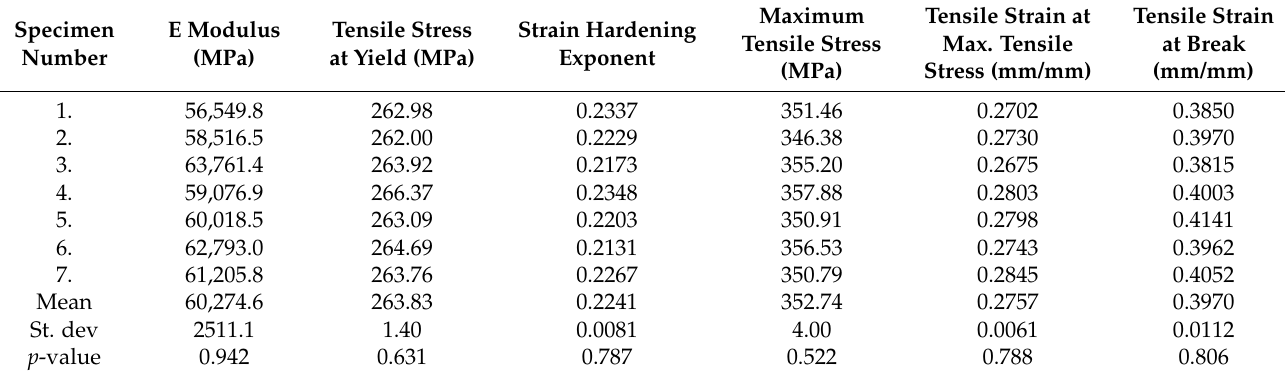
Table 4. Results of uniaxial tensile test for unwelded specimens collected on transversal direction.